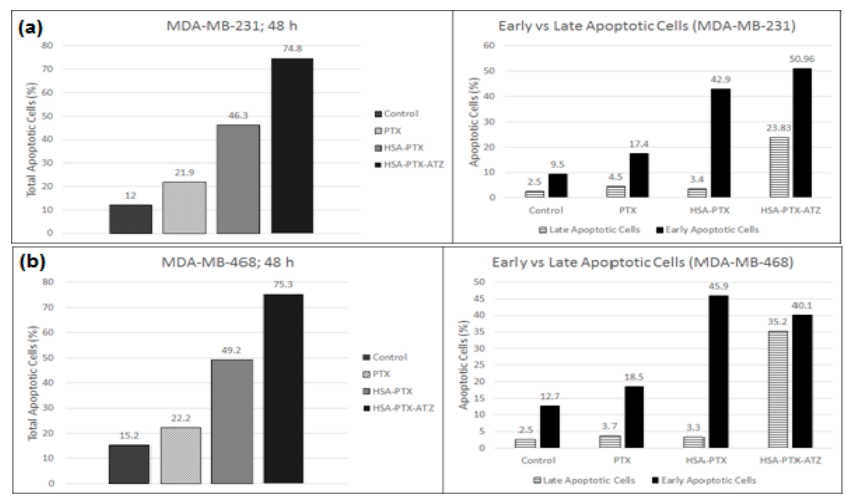
Figure 8. ( a ) Graphical representation of the apoptosis assay studies in MDA-MB-231; ( b ) Graphical representation of the apoptosis assay studies in MDA-MB-468 for the hypoxia targeting drug delivery system HSA-PTX-ATZ.